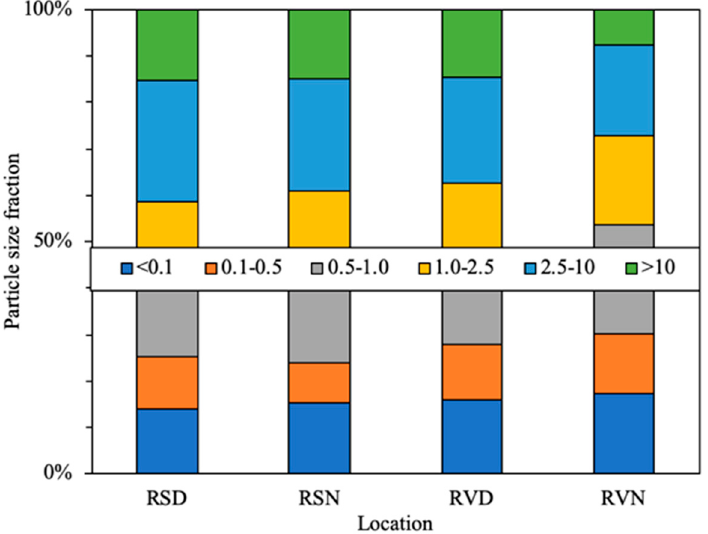
Figure 3. Size-segregated particles fraction of the airborne particles in RS and RV at diurnal and nocturnal in Jambi City.